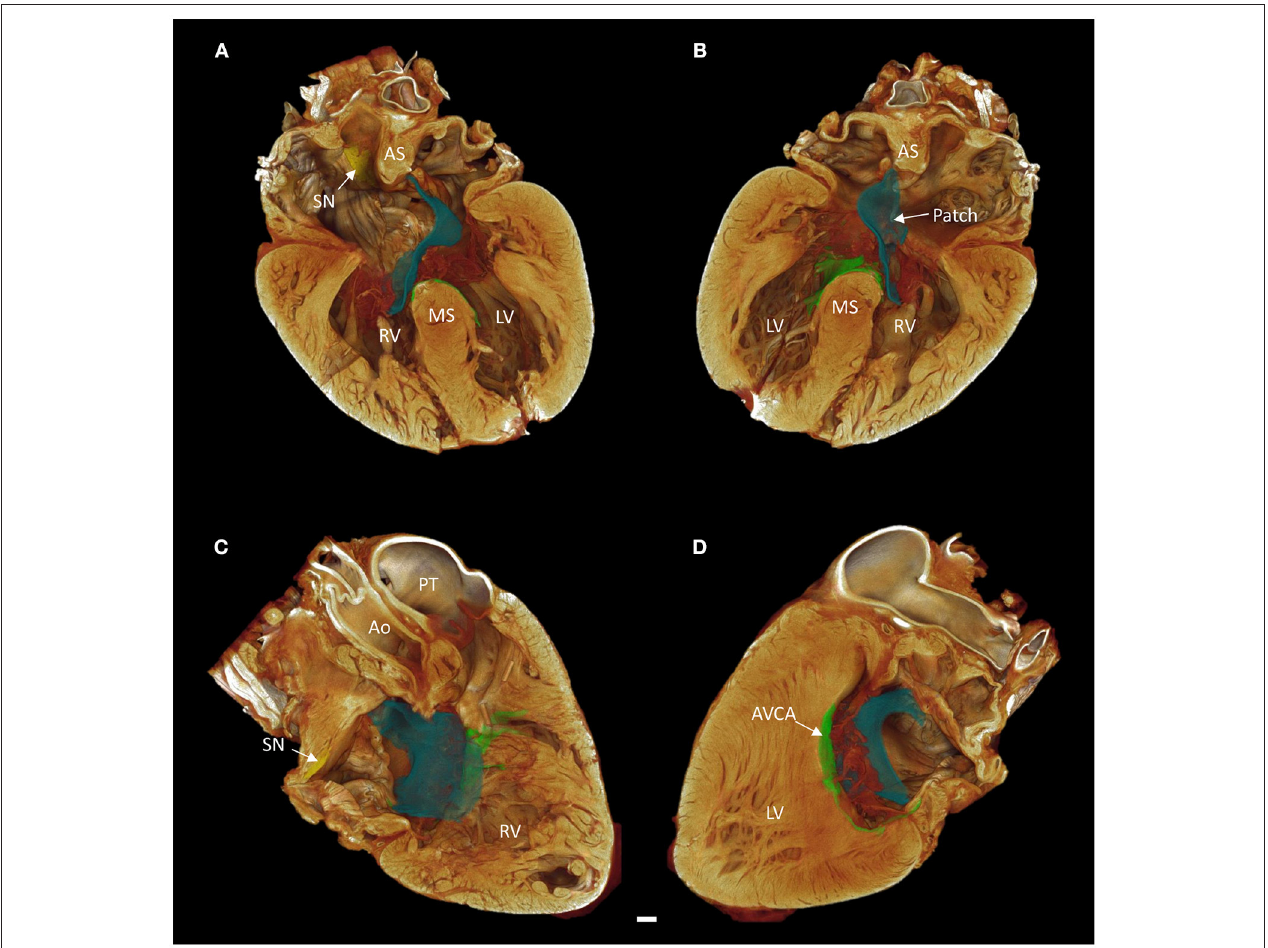
FIGURE 2 | Long axis volume renderings of a heart with atrioventricular septal defect (AVSD). (A) Anterior 4-chamber view, (B) posterior 4-chamber view, (C) right side two-chamber view, (D) left side two-chamber view. The sinus node is shown in yellow, the atrioventricular conduction axis in green, and the surgical patch in blue. Images derived from micro-CT data. Ao, aorta; AS, atrial septum; AVCA, atrioventricular conduction axis; LV, left ventricle; MS, muscular ventricular septum; PT, pulmonary trunk; RV, right ventricle; SN, sinus node. Scale bar represents